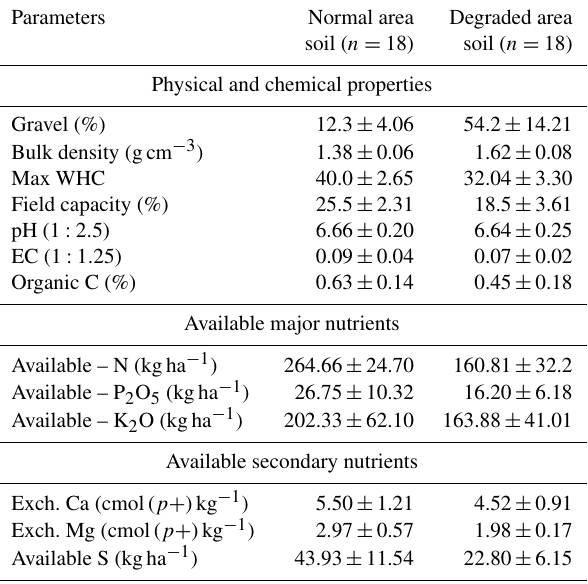
Table 1. Physical and chemical characteristics of physically de- graded wasteland soils compared to normal soils in the eastern dry zone of Karnataka. (WHC is water holding capacity; EC is electrical